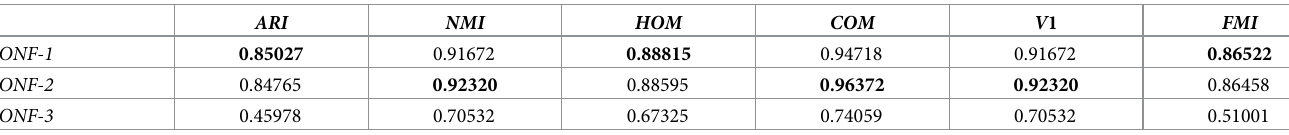
Table 5. Evaluation of the clustering